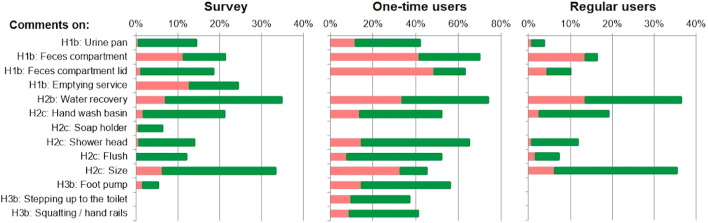
Percentages of persons of each sample mentioning features in negative (light red) and positive (dark green) comments in reply to open questions. Note: The absence of a bar means that no comments were given on a feature by this sample.